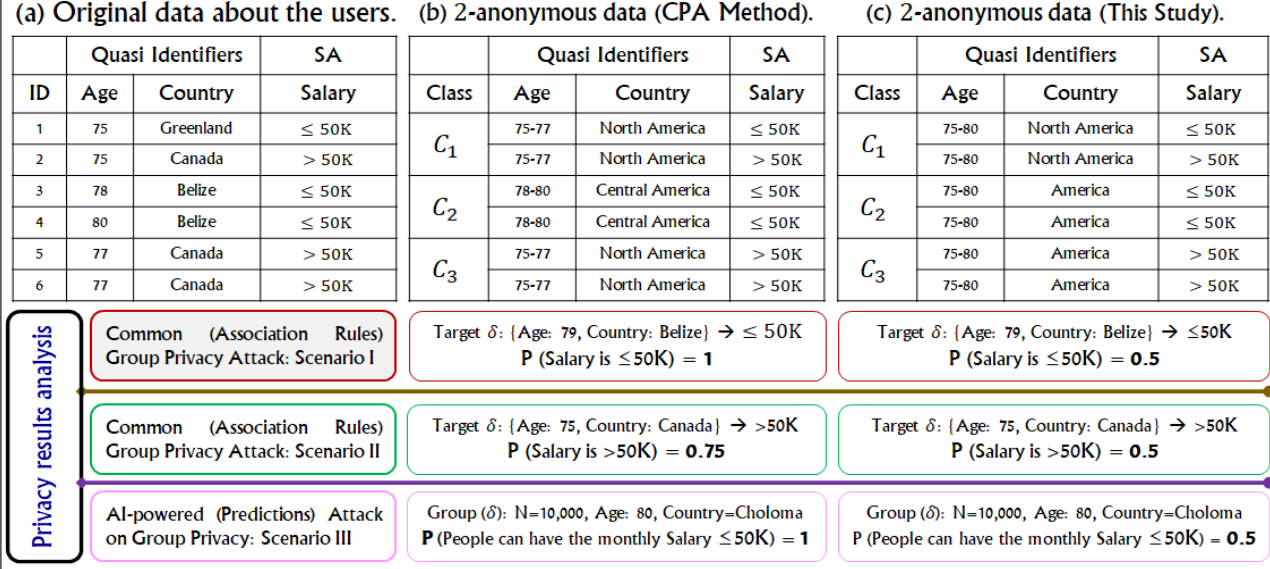
Figure 17. Comparisons of group privacy preservation: this study versus CPA